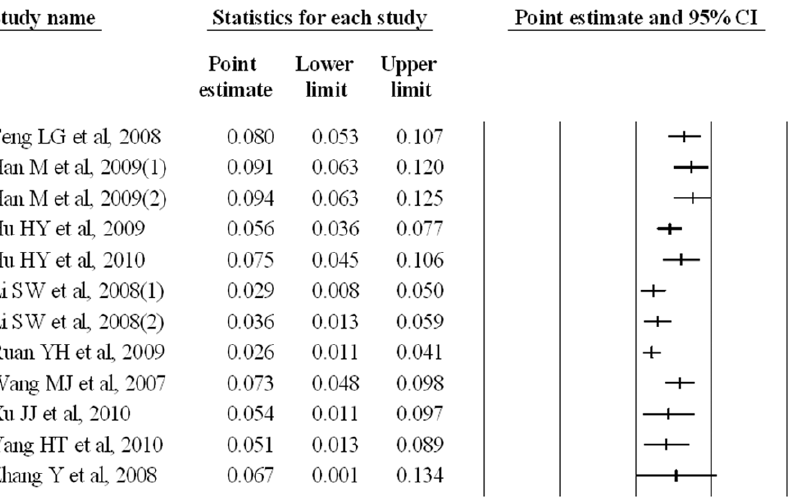
Figure 1. Crude results based on meta-analysis of studies assessing HIV incidence.